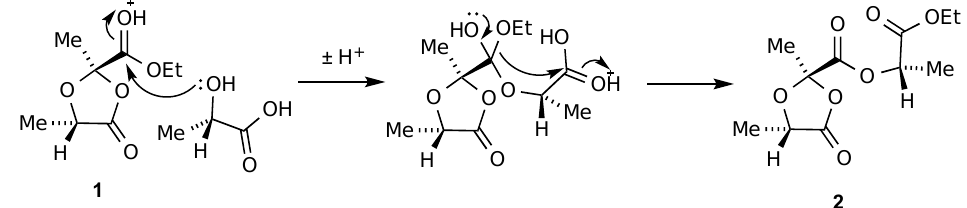
Scheme 2. Possible route for the formation of 2 from 1 with intramolecular ethoxide